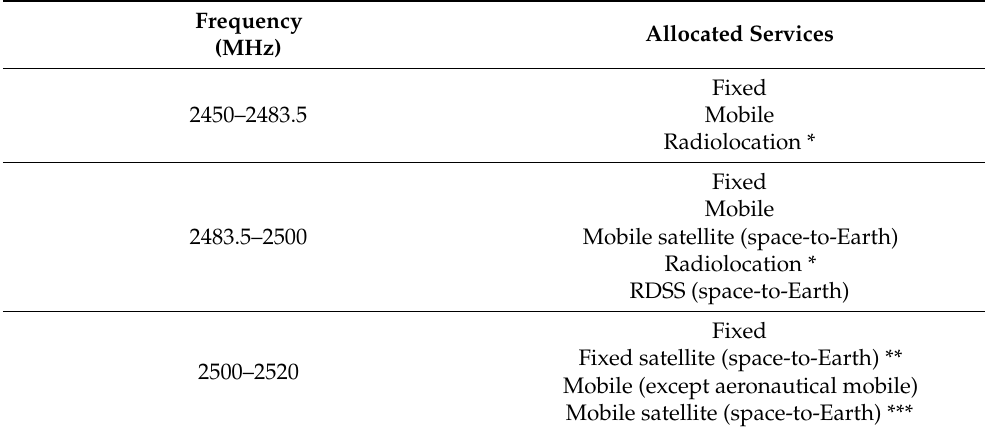
Table 1. Frequency allocations in the S-band and adjacent bands.